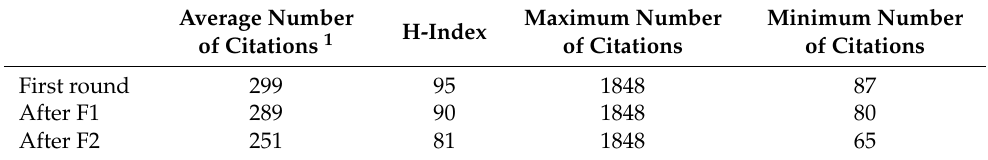
Table 1. Details of top 100 after each round of filtering.